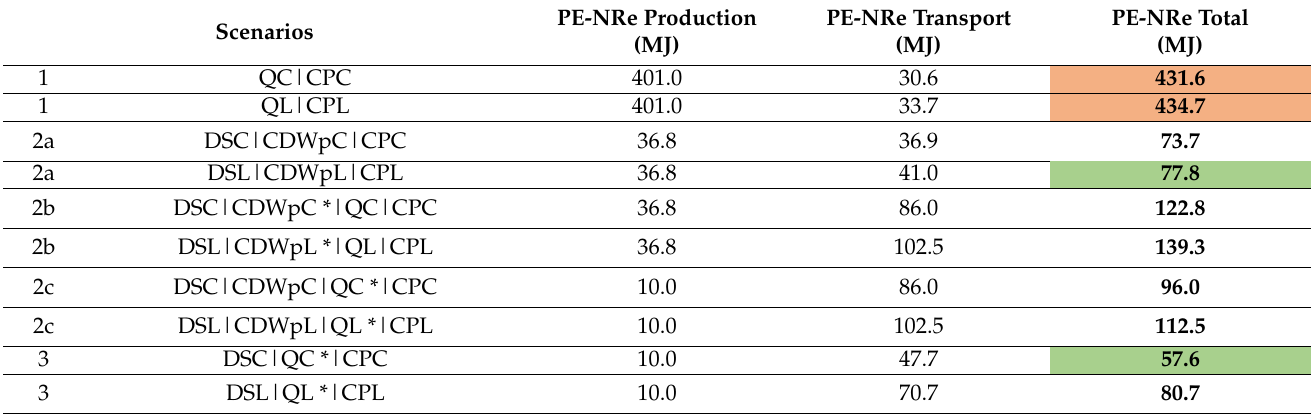
Table 5. PE-NRe for production and transport of 1 tonne of